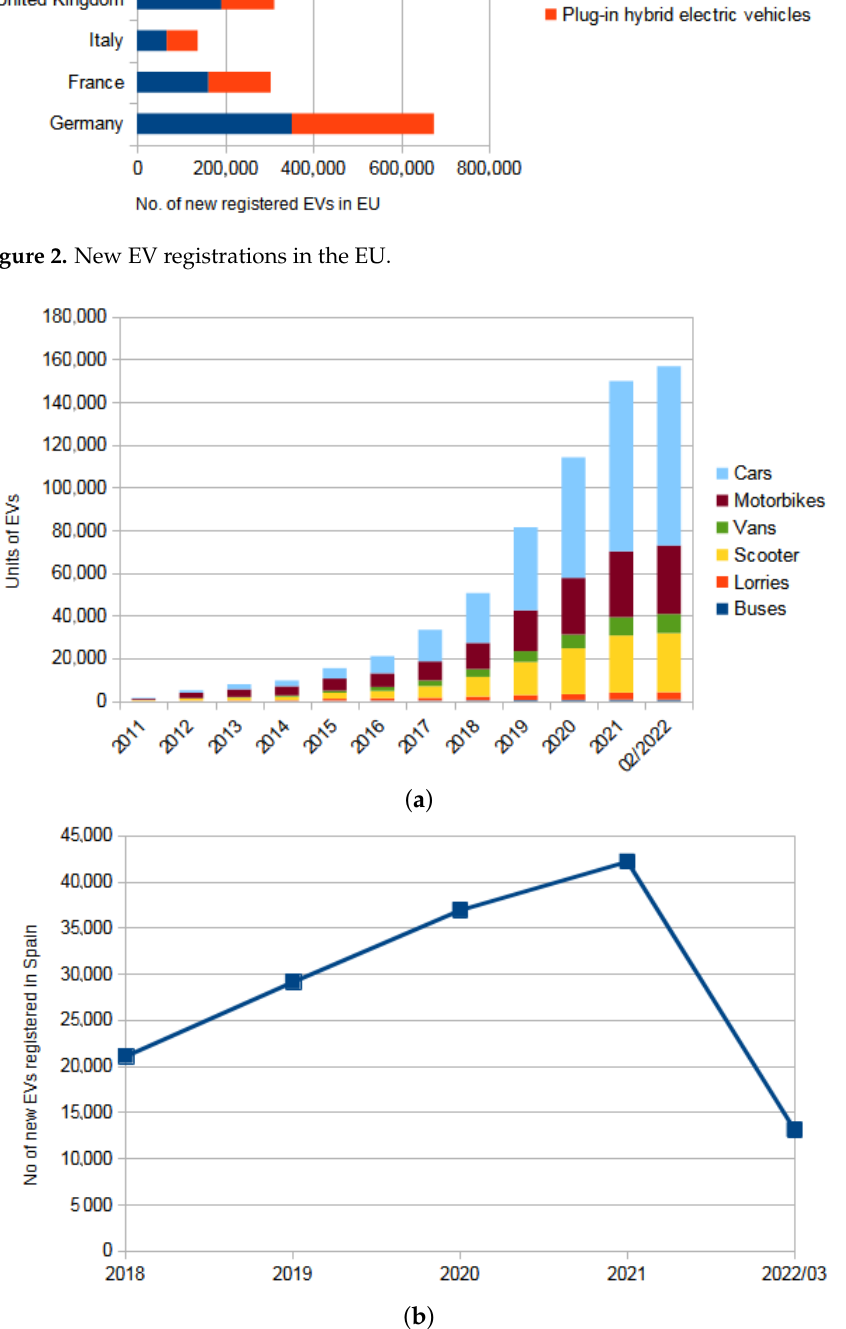
Figure 3. Evolution of EV fleets ( a ) and new registrations ( b ) in